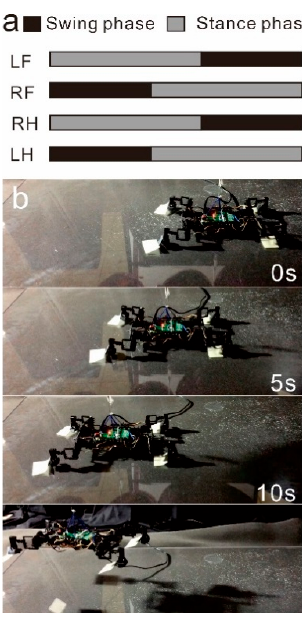
Figure 9. Experiments of robot under micro-gravity environment with diagonal gait.